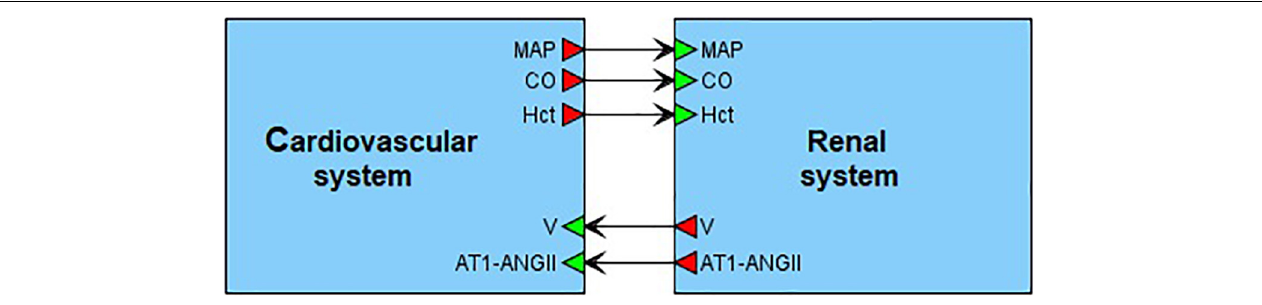
FIGURE 4 | Modular modeling of the cardiovascular and renal systems. The original model decomposed into two modules in accordance with human physiology. The “Cardiovascular system” module is responsible for calculation of such variables as mean arterial pressure (MAP) and cardiac output (CO). The “Renal system” module in turn regulates total body blood volume (V) and concentration of angiotensin II bound to the AT1 receptors (AT1-ANG II). The value of hematocrit (Hct) is constant. It is determined in “Cardiovascular system” and passed to “Renal system” for use.